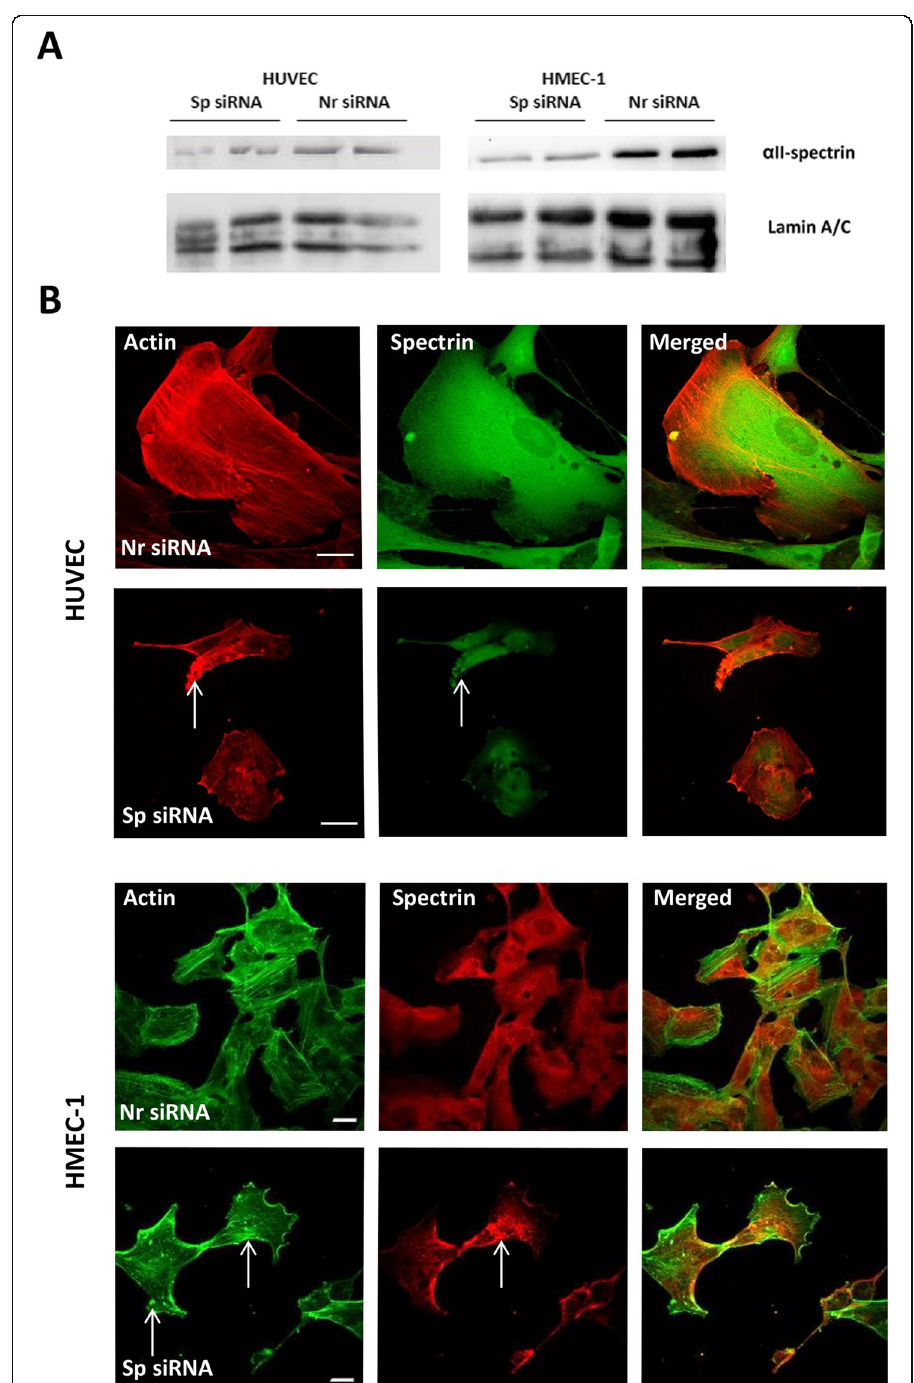
Fig. 1 (See legend on next